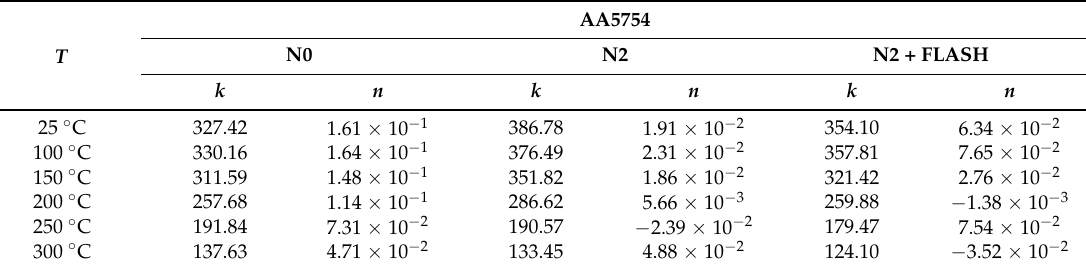
Table 6. Values for Hollomon’s parameters in the case of